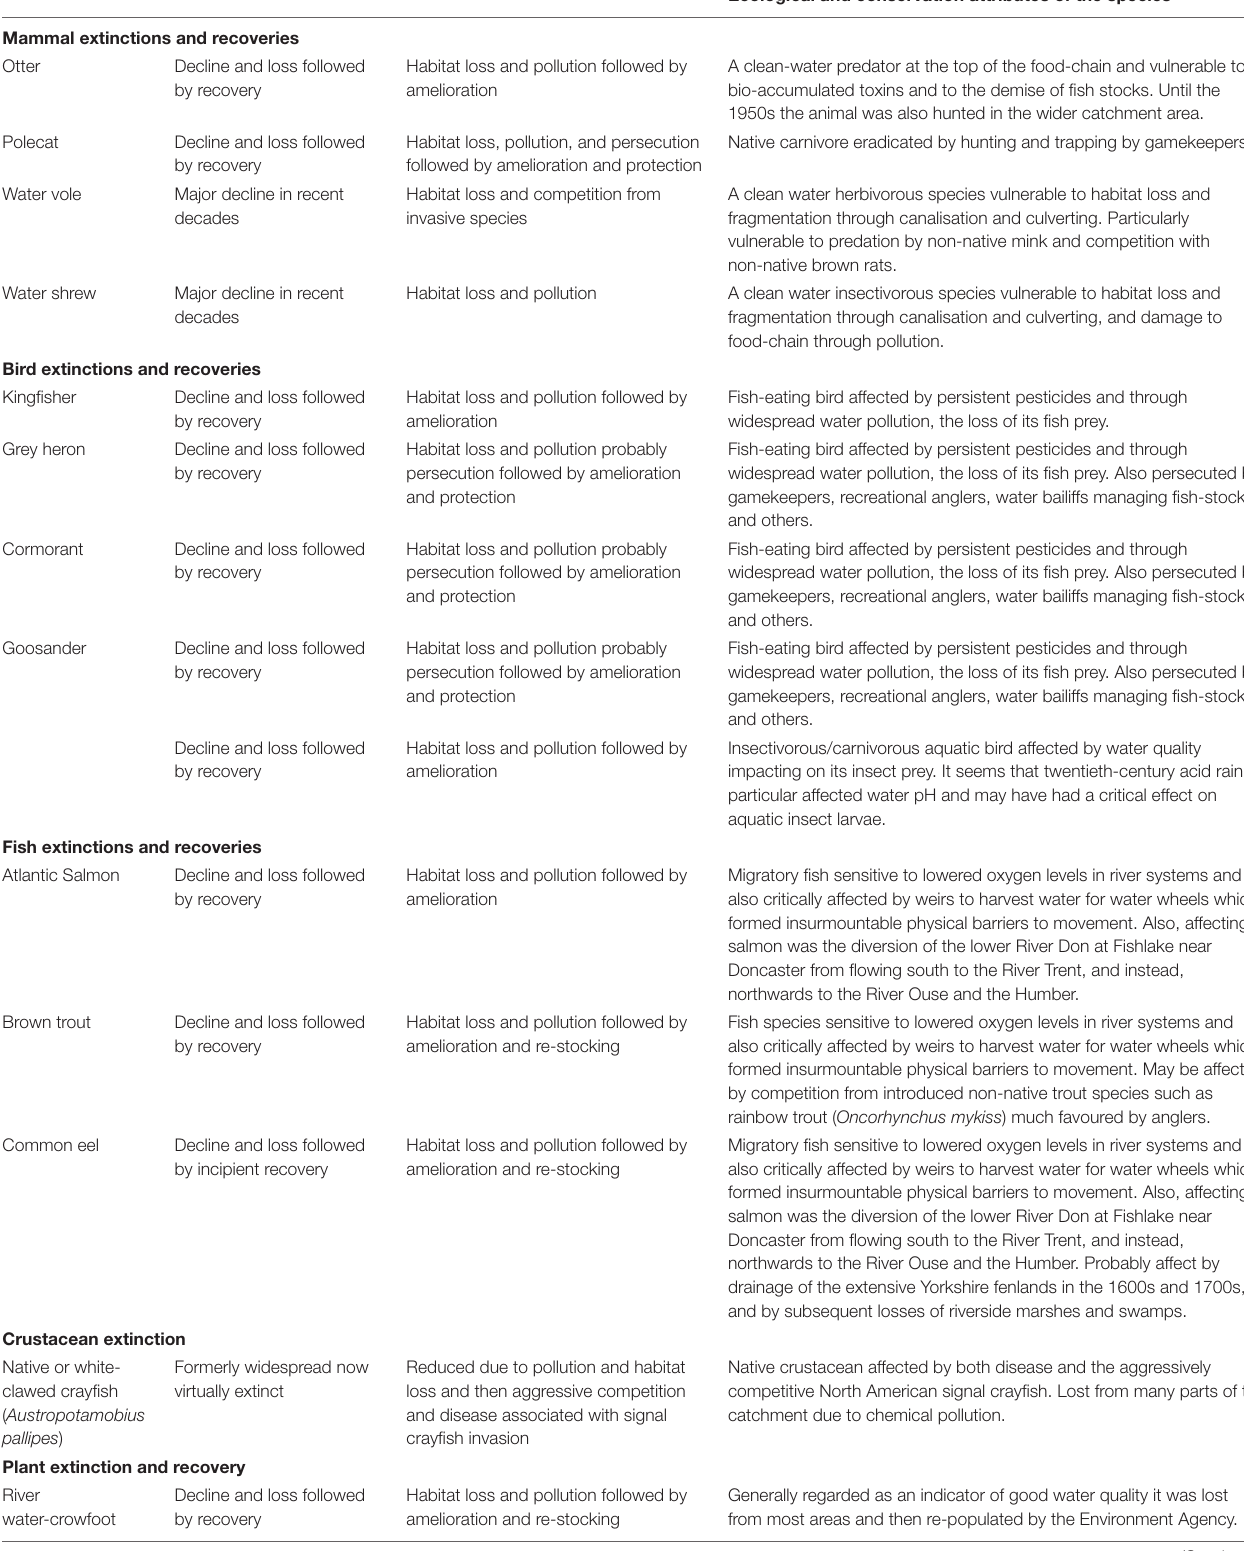
Ecological and conservation attributes of the